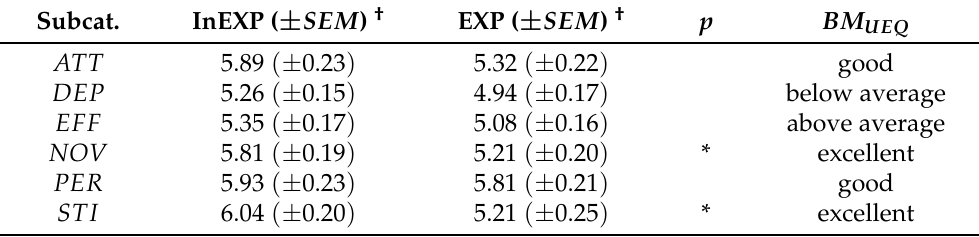
Table 1. Results of the user experience questionnaire.